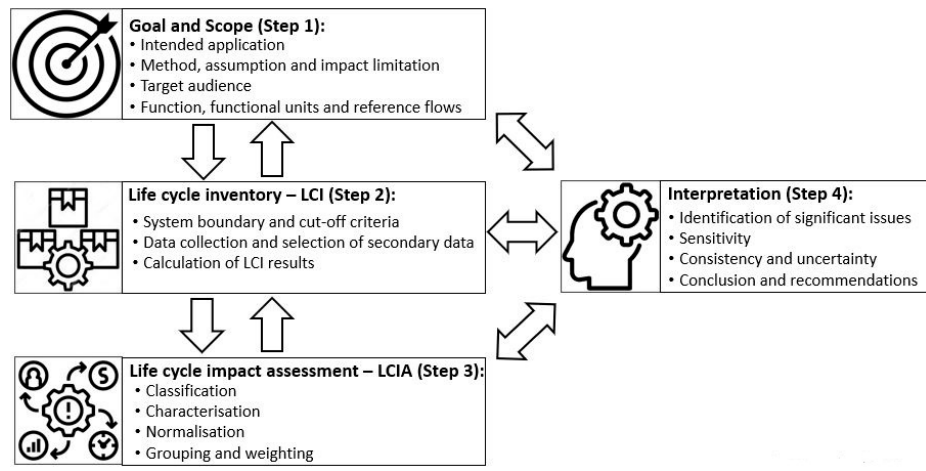
Figure 1. Life cycle assessment (LCA) framework (adapted from ISO 14040:2006 [18]).